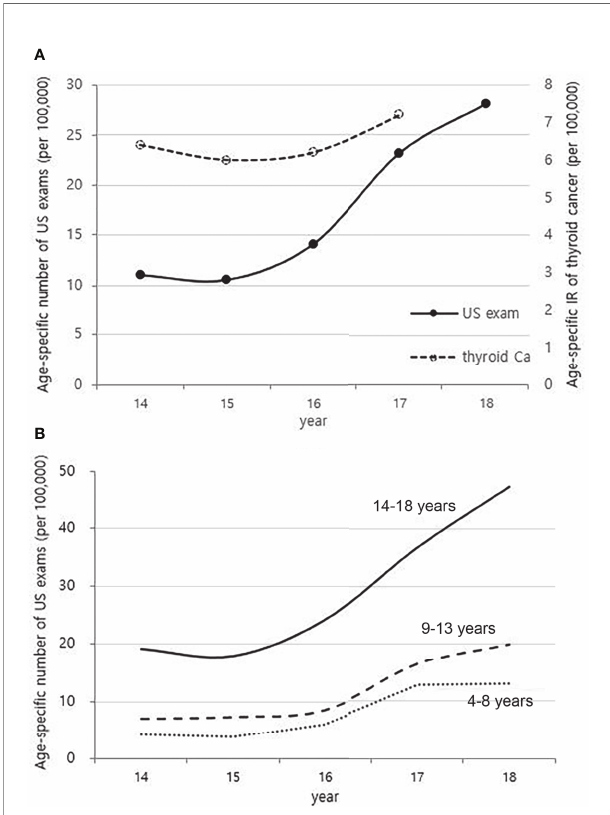
FIGURE 7 | Correlation between the age-speci fi c number of neck US exams in childhood (4-18 years) (2014-2018, per population of 100,000) and age- speci fi c incidence rate of childhood thyroid cancer (0-18 years) by year in Korea (2014-2017, per population of 100,000) (A) . Age-speci fi c number of neck US exams in childhood (4-18 years) according to age groups (2014- 2018, per population of 100,000) (B) . US, ultrasonography; Ca, cancer; IR, incidence